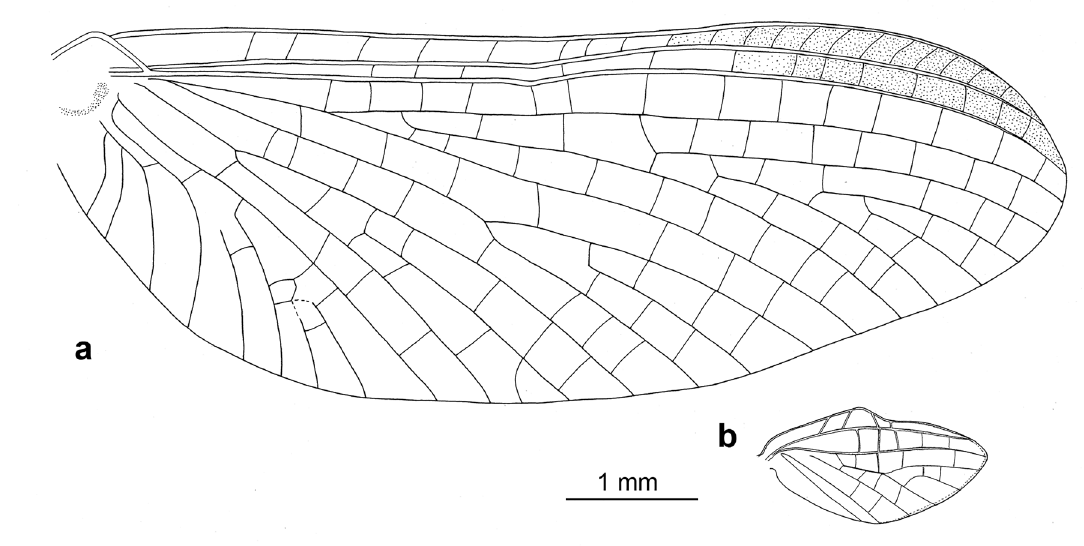
Figure 11. Calliarcys humilis Eaton, 1881, male imago [Spain; Sartori M. coll.]: ( a ) forewing; ( b ) hind wing.